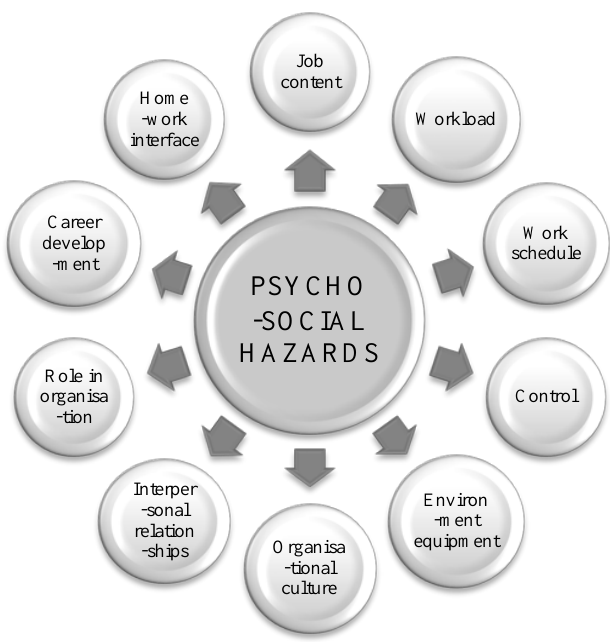
Figure 1. Psychosocial haazards related to work (Sadłowska-Wrzesińska,